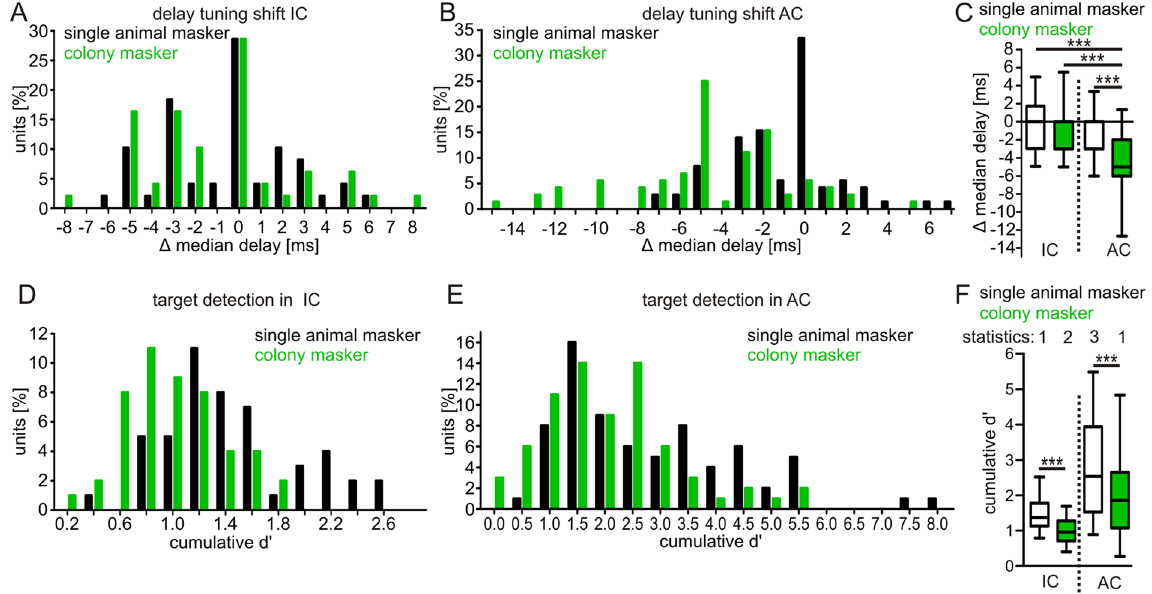
Figure 3. Robustness of neuronal processing in the presence of masker stimuli. Histograms show the median delay shifts between target and mixture response in collicular ( A ) and cortical ( B ) units. Respectively, negative and positive values indicate delay shifts towards longer and shorter delays in response to the mixture condition. ( C ) Boxplots summarize the median delay shifts in the inferior colliculus (IC) and auditory cortex (AC). ( D , E ) Histograms show the target detection, indicated by cumulative d ′ values, at neuronal level in the mixture situation in the IC ( D ) and AC ( E ). ( F ) Boxplots summarize the cumulative d ′ values calculated for the IC and